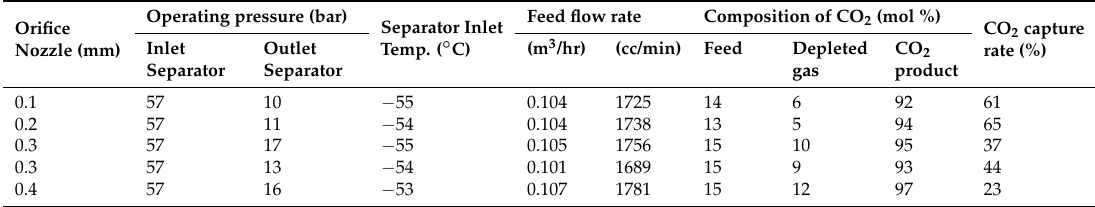
Table 3. Experimental results and material balance for each equilibrium condition tested.